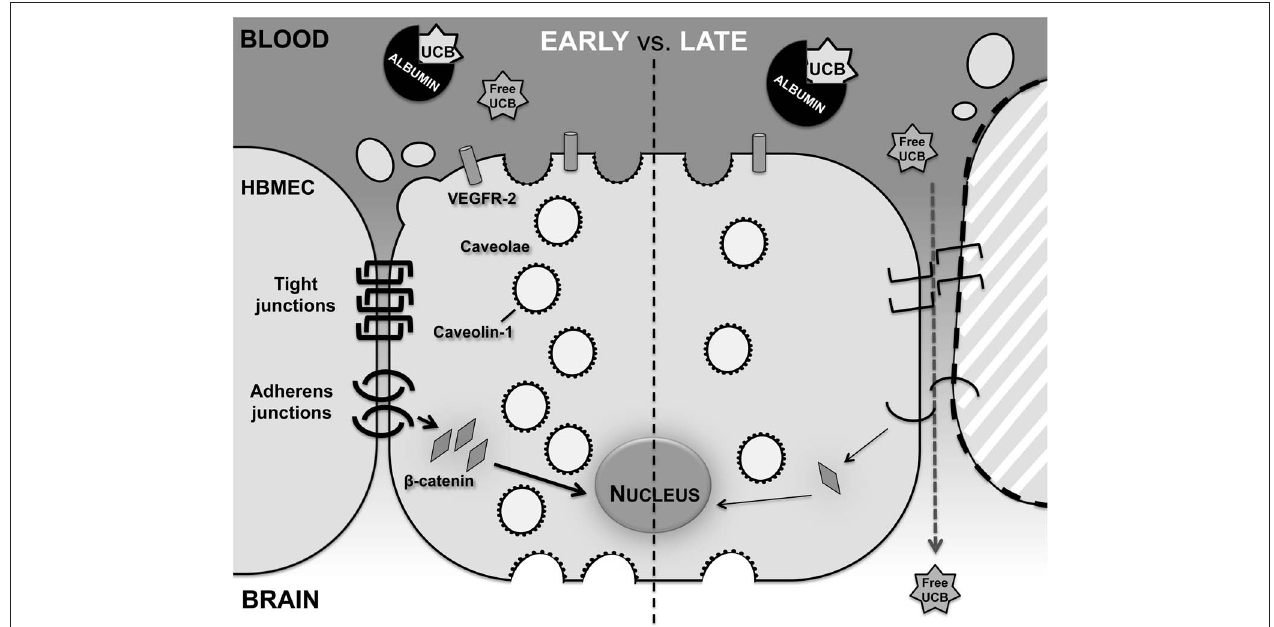
FIGURE 8 | Effects of UCB on HBMEC differ between an early and late exposure. HBMEC early response includes increased number of caveolae and levels of caveolin-1 and VEGFR-2, while a delayed response presents alterations in the transendothelial properties of the HBMEC